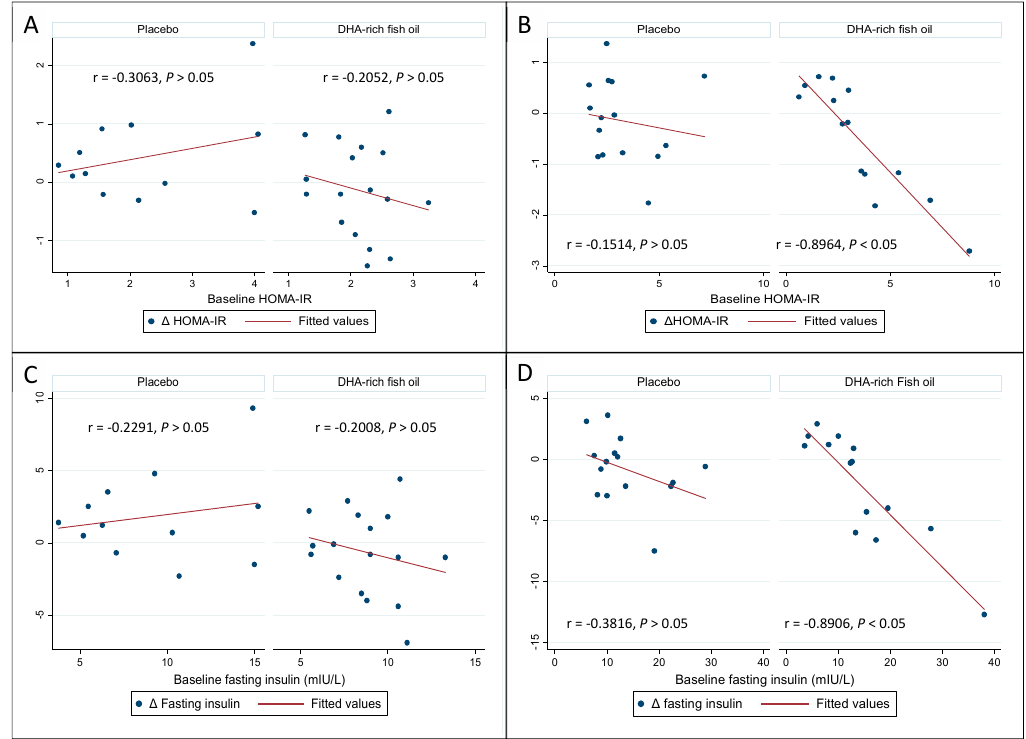
Figure 5. Pearson’s product–moment correlations exhibiting relationship between baseline HOMA-IR and fasting insulin values and responses to intervention in placebo and DHA-rich fish oil groups in study participants with C-reactive protein < 2.4 mg / L ( A , C ) and ≥ 2.4 mg / L ( B , D